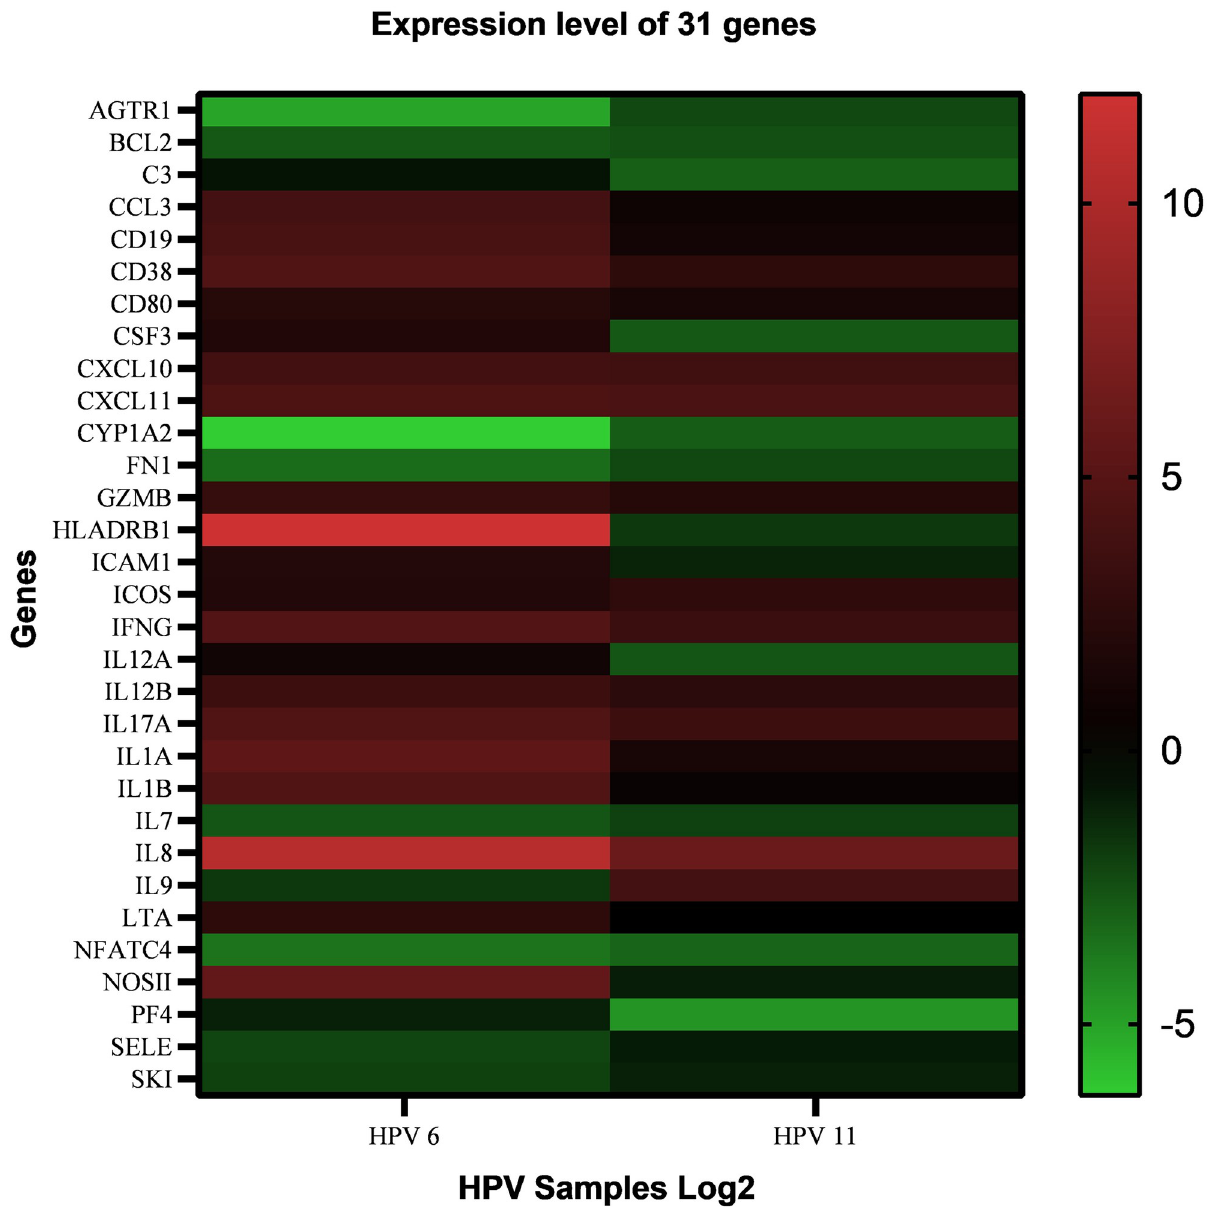
Fig 1. Heatmap of 31 differentially expressed genes in condyloma acuminata samples. A numerical version of Fig 1 is presented in S6 Table.